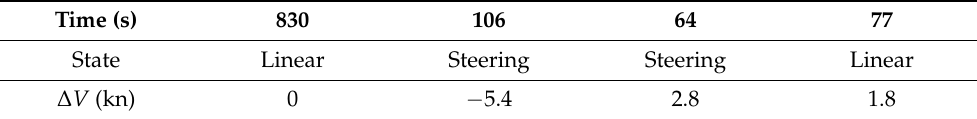
Table 8. Maneuver